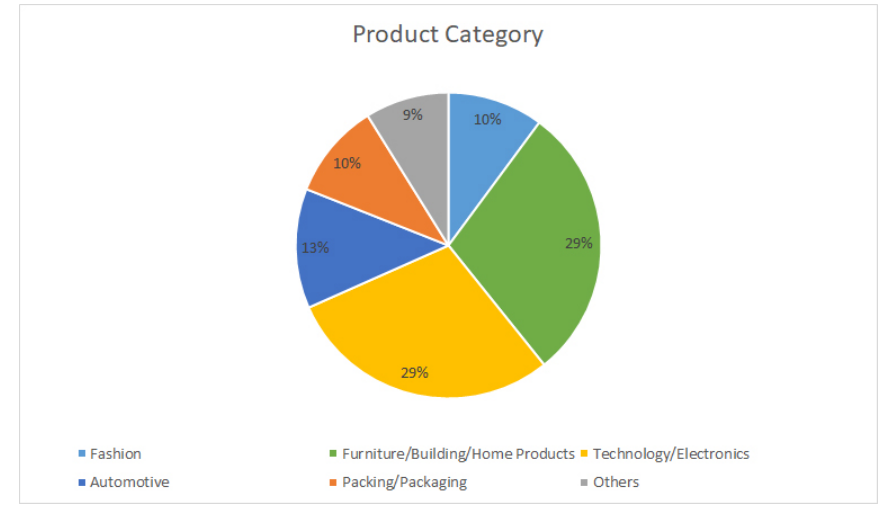
Figure 9. Classification by product